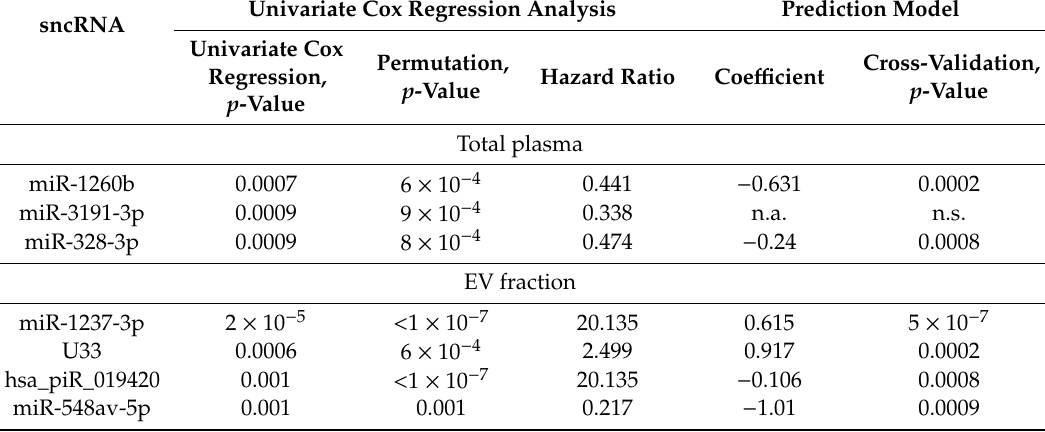
Table 2. SncRNAs associated with overall survival of MDS patients. Prediction model coe ffi cients are applicable to the formula of survival risk score. The survival risk score of a total plasma sample = + 6.861. Similarly, the survival − 0.631 × log − 0.24 × log 2 (level of miR-1260b) 2 (level of miR-328-3p) risk score of an EV sample = 0.615 × log 2 (level of miR-1237-3p) + 0.917 × log 2 (level of U33) − 0.106